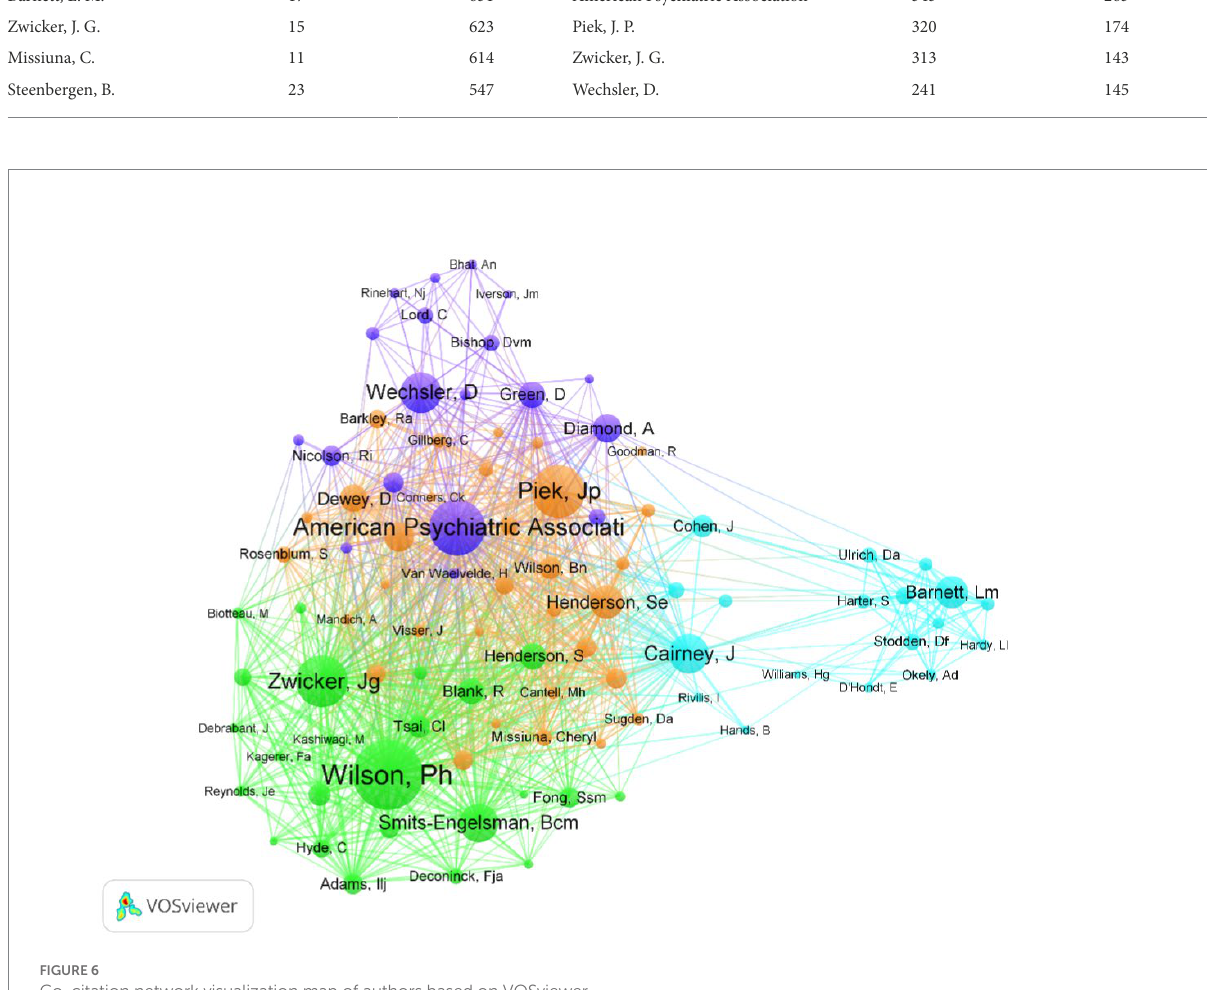
FIGURE 6 Co-citation network visualization map of authors based on VOSviewer.